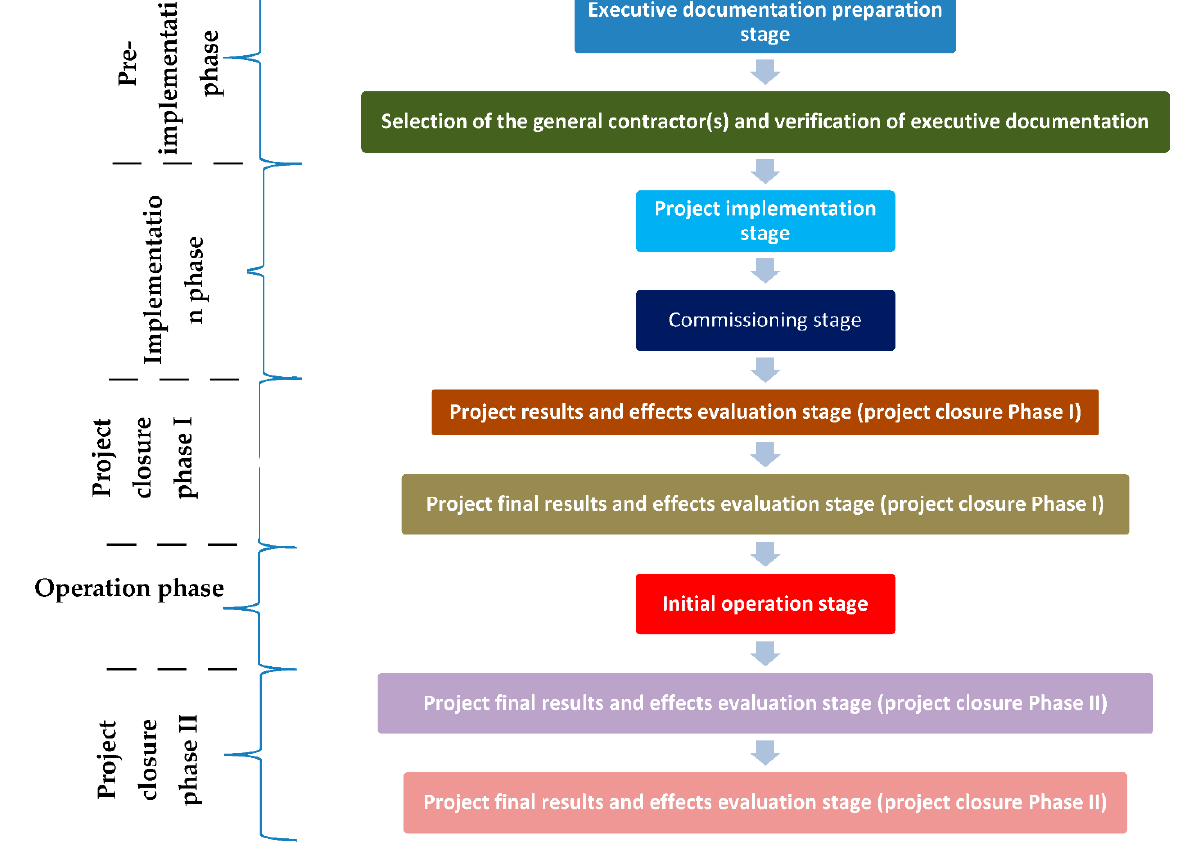
Figure 2. Investment process model (16 stages grouped in eight phases).